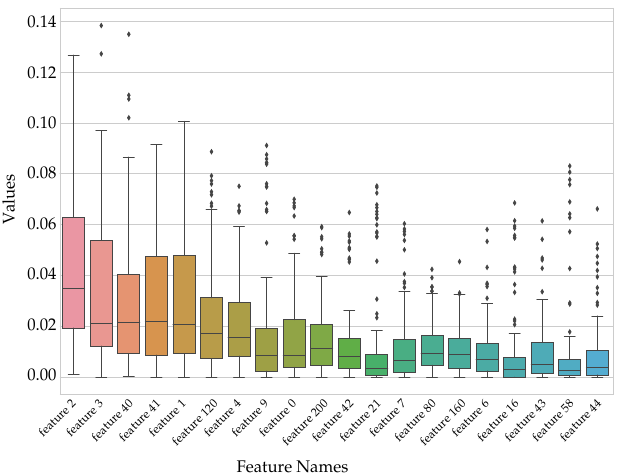
Figure 8. Box plot showing the first 20 sorted MDI